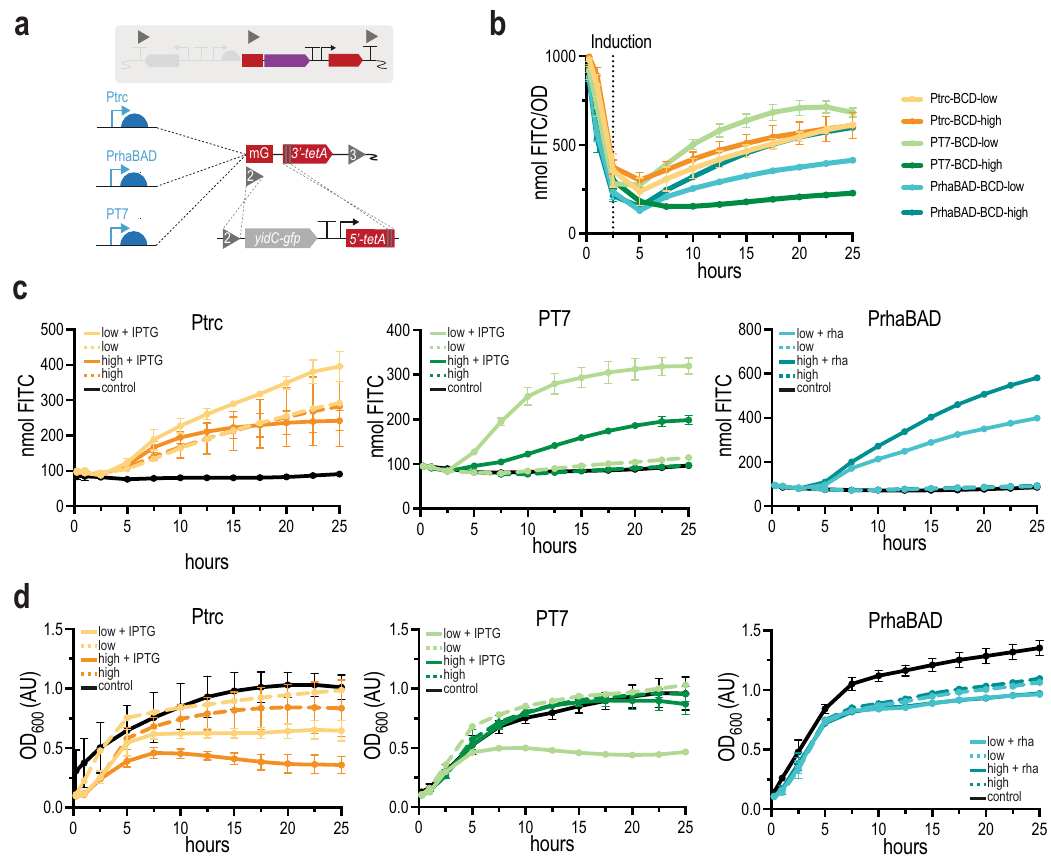
Fig. 4 Production of the toxic protein YidC-GFP with different SEGA control elements. a To show the bene fi t of simultaneous integration of one PCR product in several SEGA strains, yidC-gfp was integrated into six different SEGA strains with different C1 control elements with low and high TIRs and a BCD gadget using homologous recombination at recombination site 2 and the truncated tetA gadget. b Production of YidC-GFP (nmol FITC) in six different SEGA strains was measured over 25 h and normalized to cell density. Cells were induced after 2.5 h. c Absolute production of YidC-GFP (nmol FITC) was measured for 25 h for all constructs. d Growth (OD 600 ) was measured for 25 h for all constructs. All measurements represent the mean of three biological replicates with standard deviations, except the sample Ptrc-low uninduced (data obtained from a single experiment). Source data are provided in the Source data fi